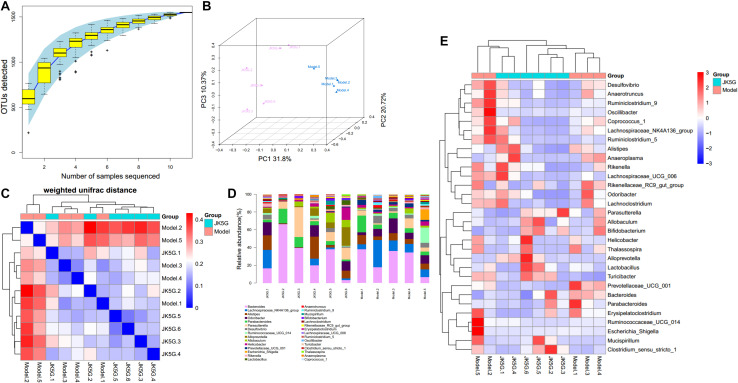
Different flora analysis on the model versus control groups and the microecological preparation versus model groups. Specaccum species accumulation curve (A), principal component analysis (B), β diversity index (C), the bluer the color, the closer the distance between the samples, the higher the similarity, and the farther the red color; histogram of colony composition (D), the heat map of community composition (E).